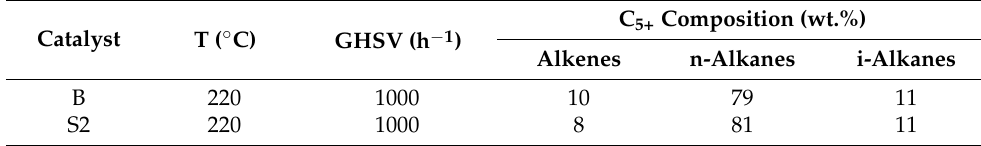
Table 3. Composition of C 5+ hydrocarbons, obtained over S2 and